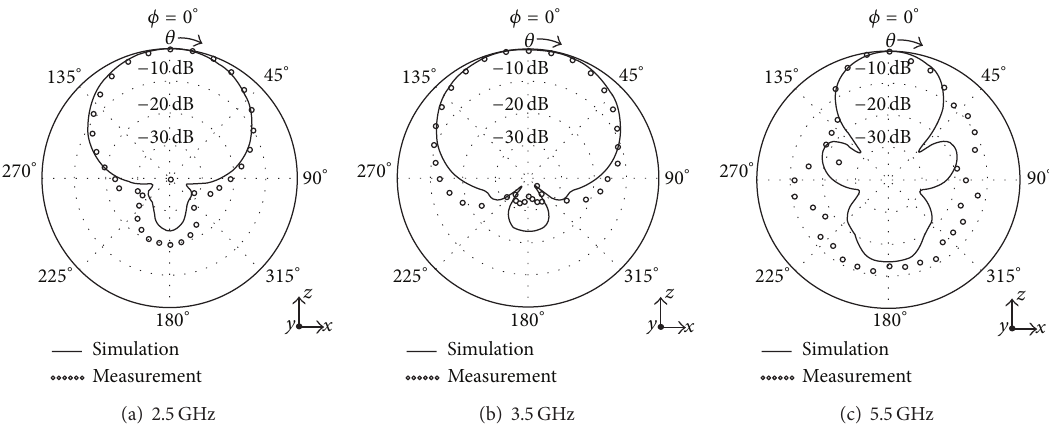
Figure 12: The comparison between the simulated and measured radiation patterns in the 𝑥𝑧